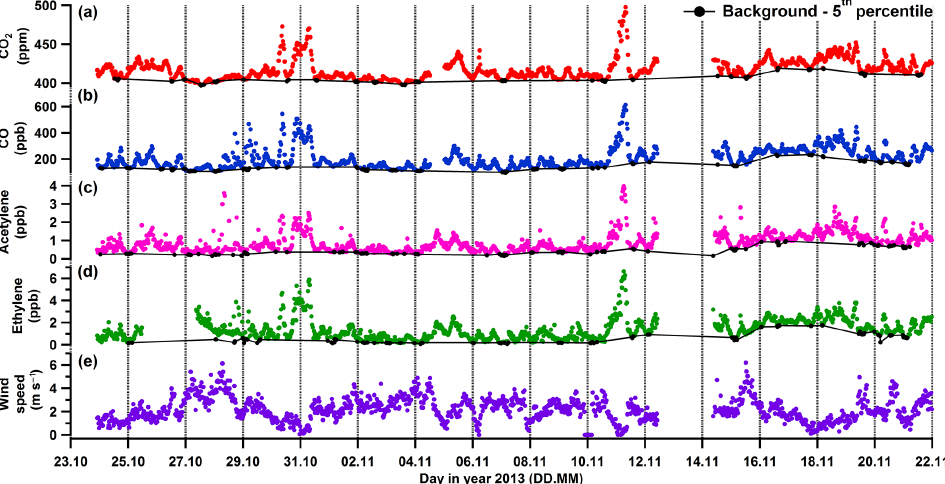
Figure 1. (a–d) Temporal variation of the mole fraction of selected compounds monitored during the Multi-CO 2 campaign (30min time step). The black lines represent the background levels defined with the calculation of the 5th percentile (black disks). (e) Wind speed during the campaign. Time is given in